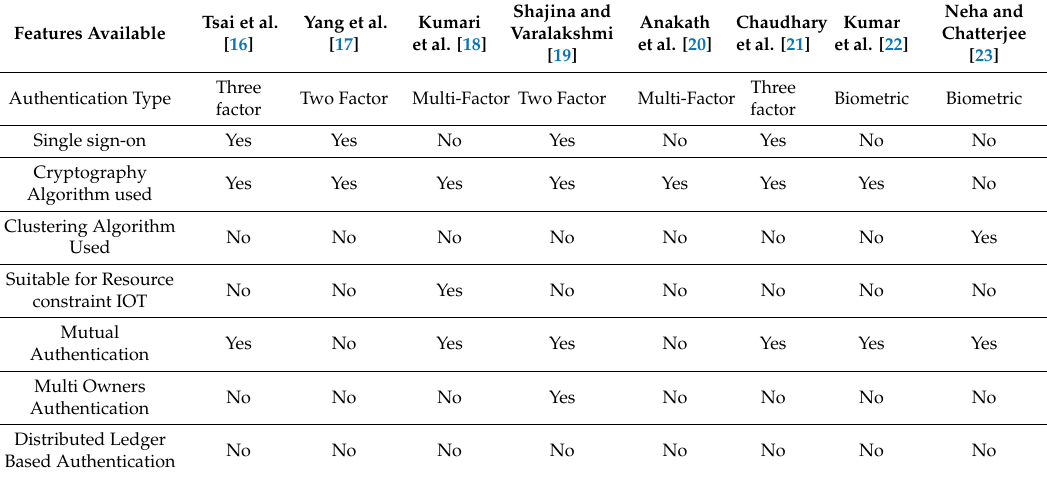
Table 2. Comparison of di ff erent authentication techniques for an outsider